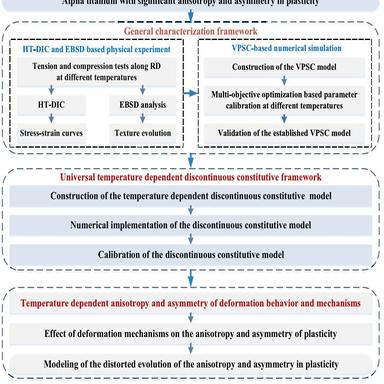
The proposed characterization and modeling framework.